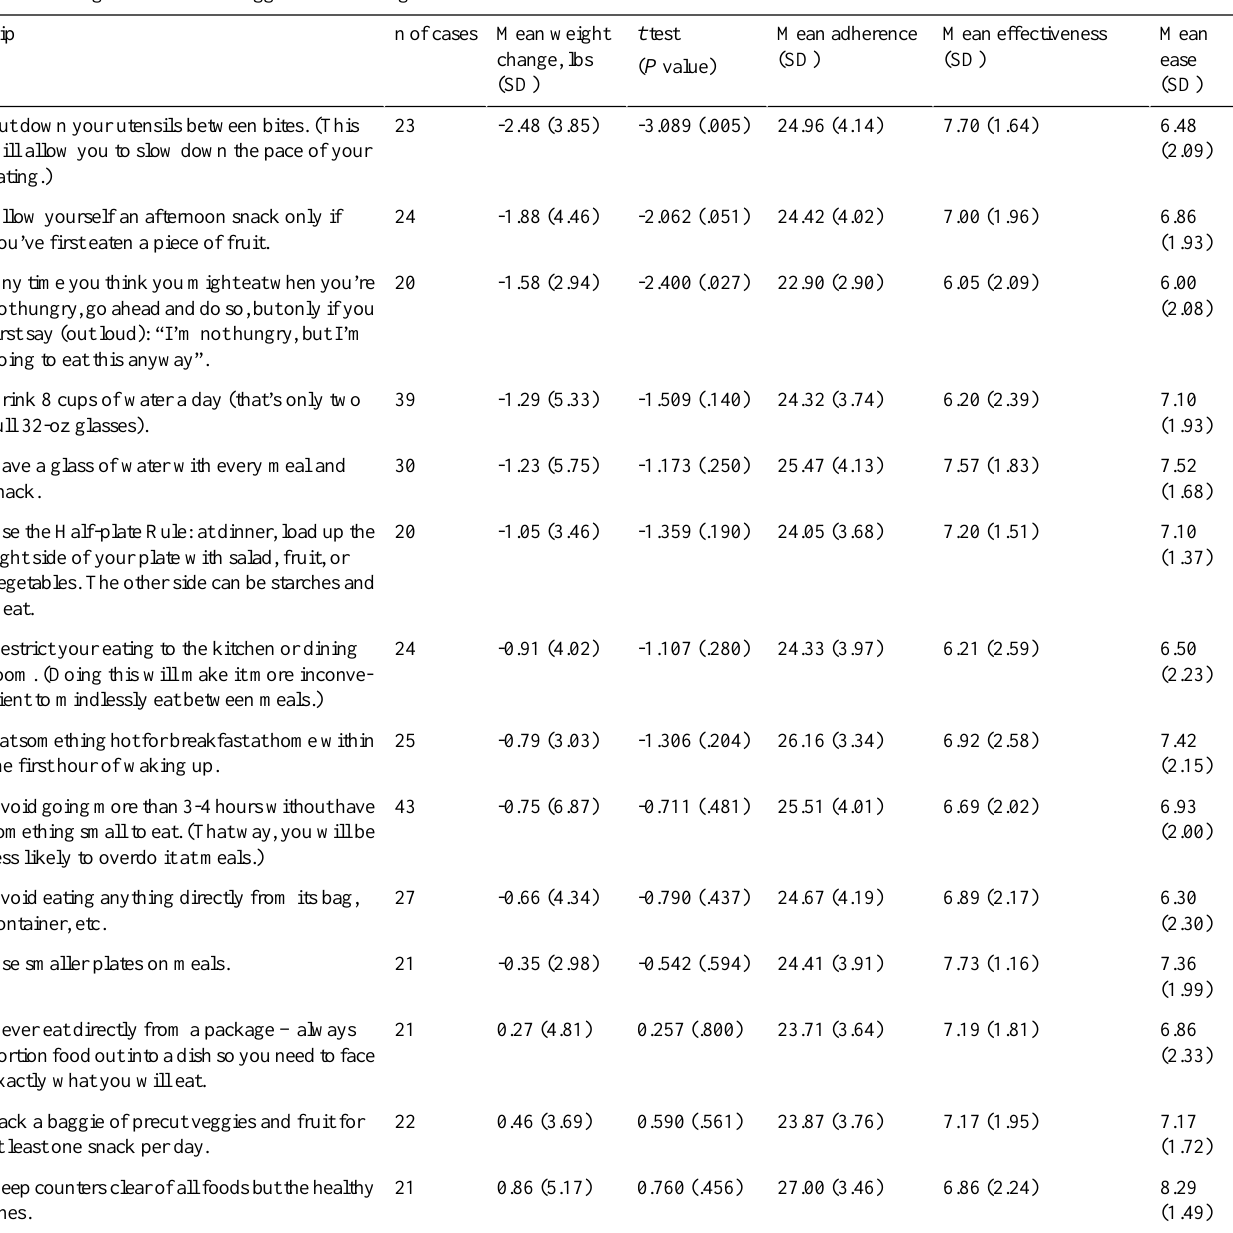
Table 3. Weight outcomes of suggestions with high